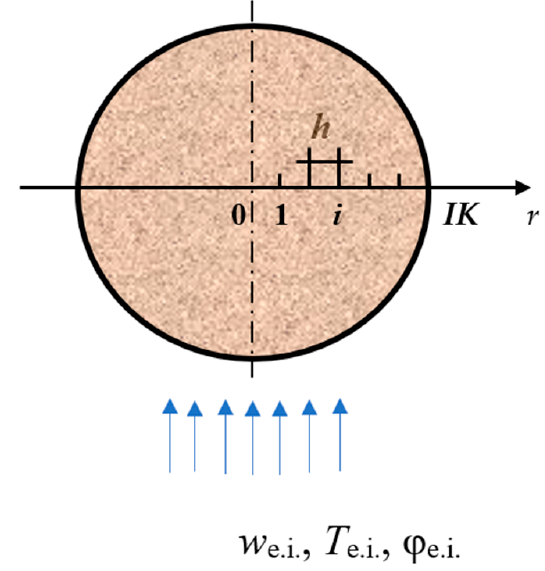
Figure 1. View of the computational domain.